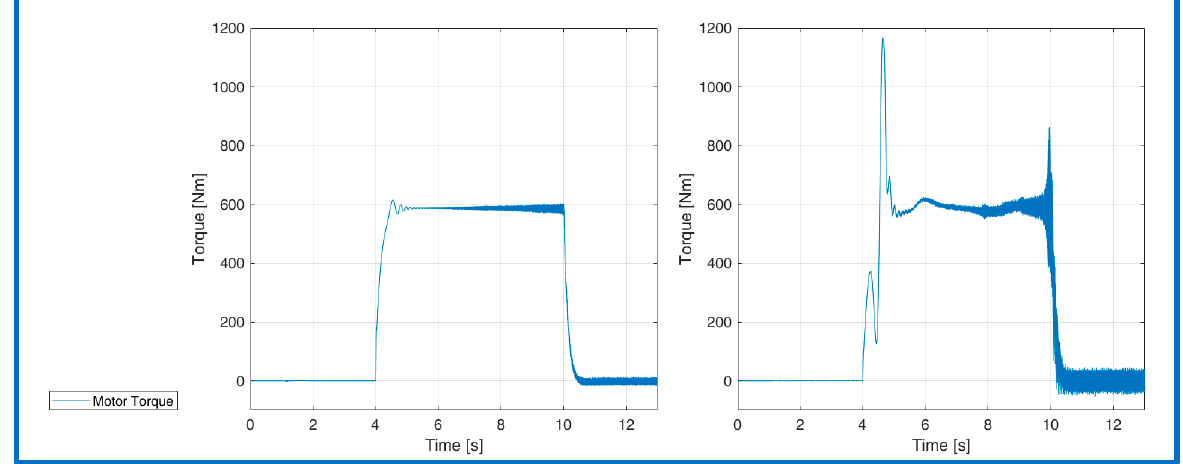
Figure 12. Motor torque with ideal generators (left) and with inverter (right).